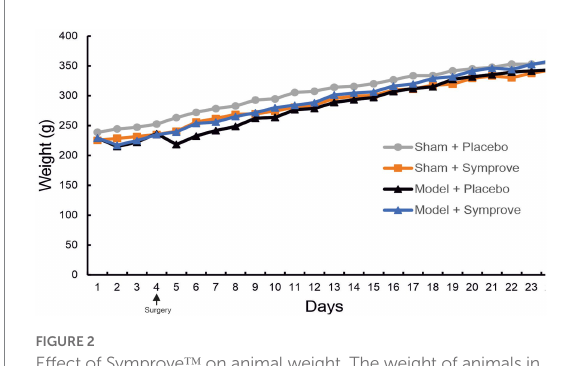
FIGURE 2 Effect of Symprove ™ on animal weight. The weight of animals in the four experimental groups (Sham + placebo, Sham + Symprove ™ , Model + placebo and Model + Symprove ™ ) was monitored daily from Day 0 until Day 24. Treatment with Symprove ™ did not affect the steepness of the growth curve, suggesting a similar weight gain in all experimental groups. Interestingly, PD model animals that received Symprove ™ did not display the loss of weight usually observed after the stereotaxic surgery at Day 5.